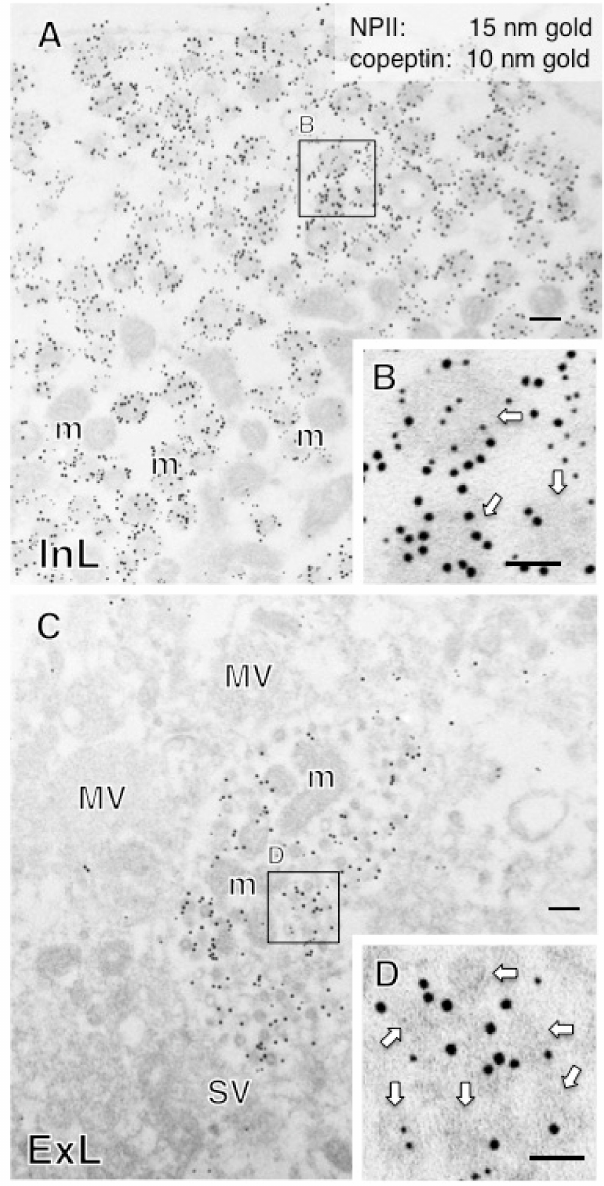
Figure 4. Double-label immunoelectron microscopy for vasopressin-associated neurophysin (NPII) and copeptin in the internal layer (InL; ( A , B )) and external layer (ExL; ( C , D )) of the macaque median eminence. Numerous dense-cored neurosecretory vesicles located in some of the varicosities were immunopositive for both copeptin (10-nm gold particles) and NPII (15-nm gold particles). The outlined area in ( A ) and ( C ) is enlarged in ( B ) and ( D ), respectively. Scale bars, 200 nm, and 100 nm in enlarged images. Arrows indicate dense-cored neurosecretory vesicles. m, mitochondrion; MV, clustered